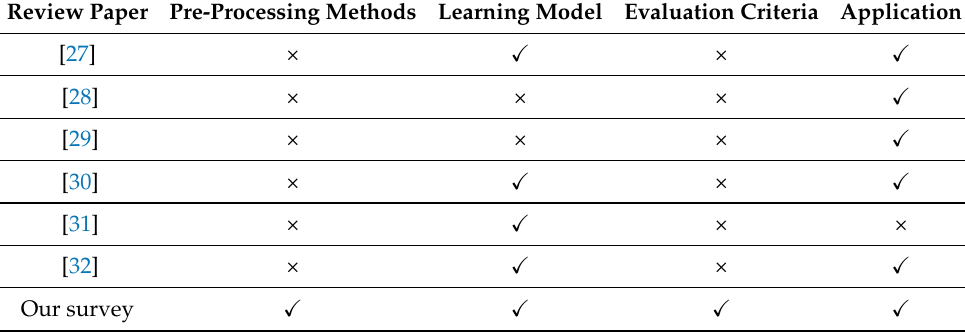
Table 2. Comparison between our review paper and other review papers. Review Paper Pre-Processing Methods Learning Model Evaluation Criteria